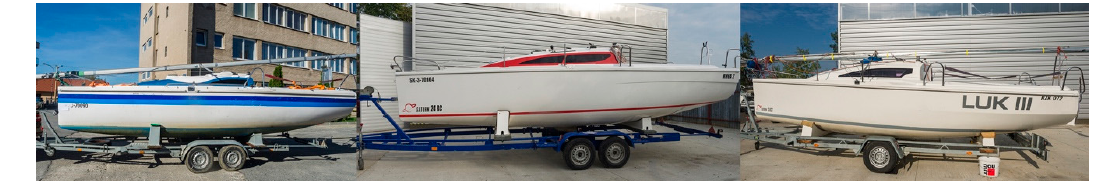
Figure 3. Objects of racing cabin sailboats selected for measurements (from the left—Saturn 720; Saturn 23GT; Saturn 24RC).